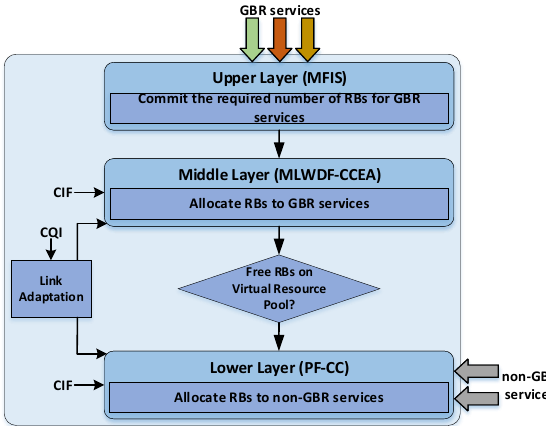
Figure 1. The layer stack of the proposed